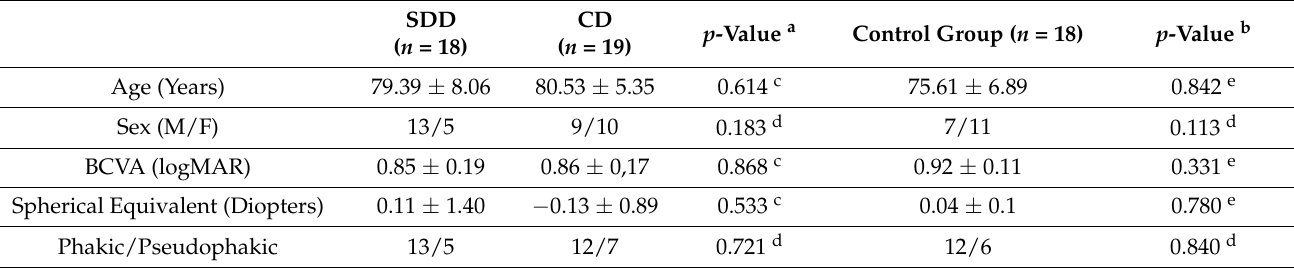
Table 1. Demographic data of patients with subretinal drusenoid deposits (SDD), conventional drusen (CD), and con- trol